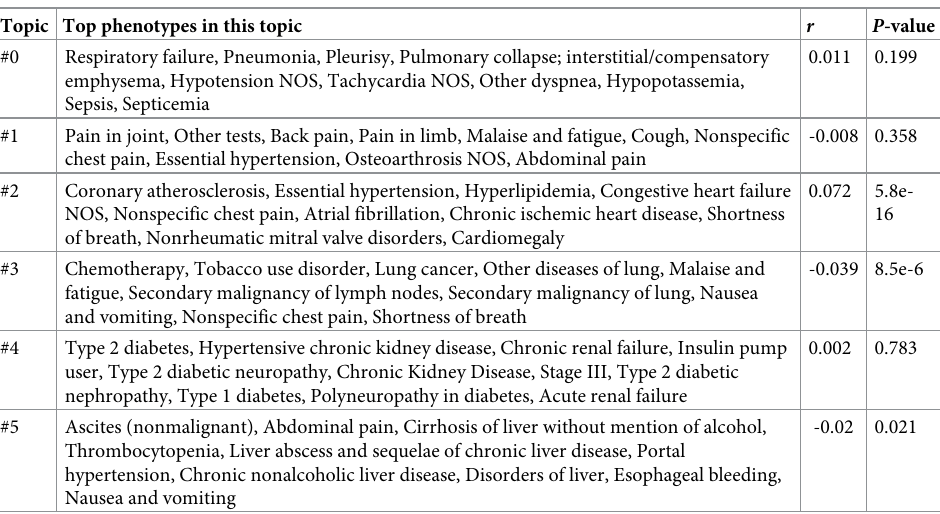
Table 1. Pearson correlation coefficient testing between LPA variant for each topic.